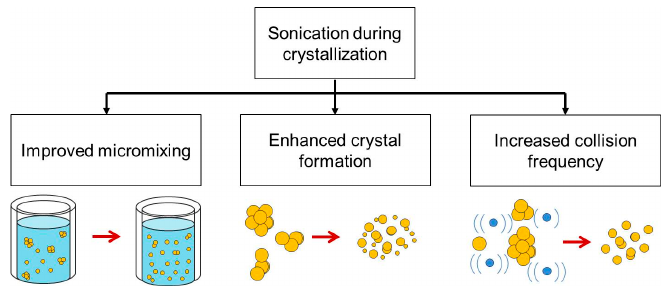
Figure 10 . Schematic overview of the proposed mechanism by which sonication inhibits during agglomeration during crystallization.